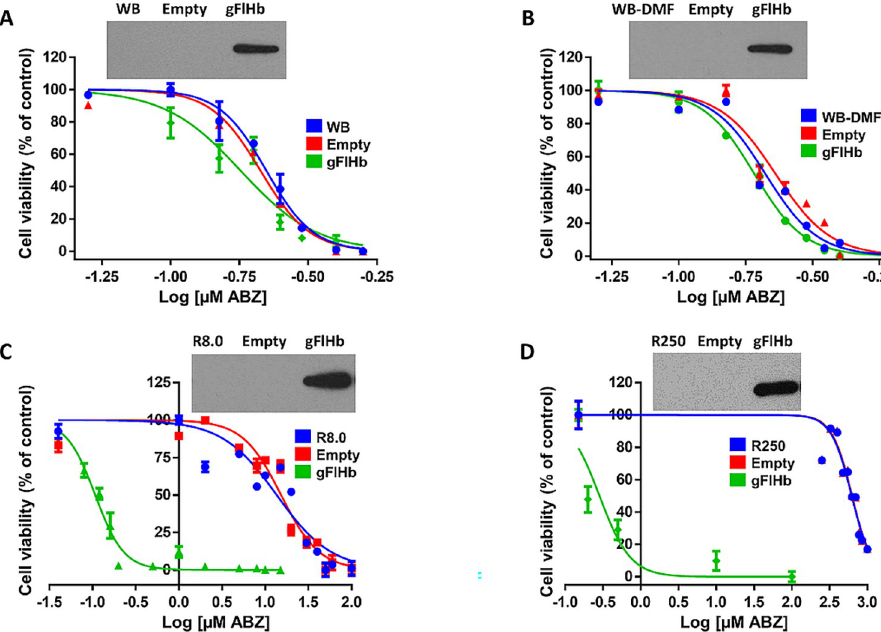
Fig 11. Concentration-viability curves of ABZ-susceptible and ABZ-resistant G . duodenalis trophozoites transfected with empty vector and pAC-gFlHb exposed to ABZ. (A) WB, (B)WB-DMF, (C) R8.0, and (D) R250 clones. Western blots indicating gFlHb overexpressed in trophozoites are shown in the upper part of the figure. Trophozoites were exposed to increasing ABZ concentrations (shown in logarithmic scale) for 24 h and cellular viability was determined by Trypan blue exclusion. The IC 50 values correspond to n = 3 independent experiments. Standard deviations are shown for each ABZ concentration and for each IC 50 determined.